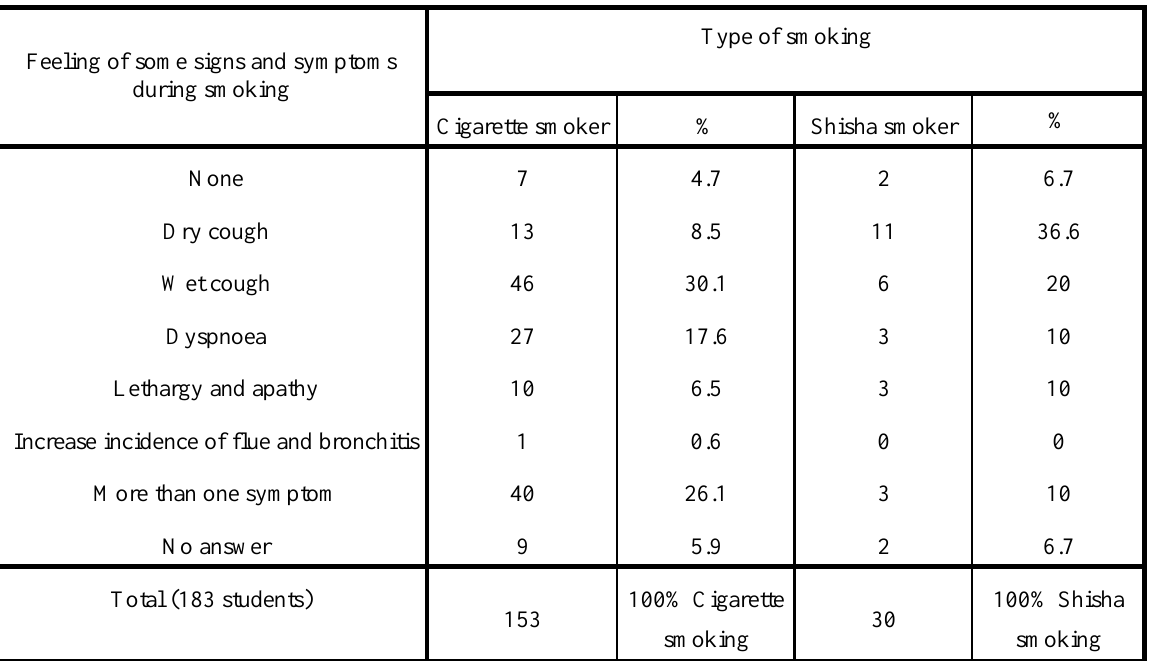
Table 5 The prevalence of various signs and symptoms associated with smoking among students in relation to type of smoking.